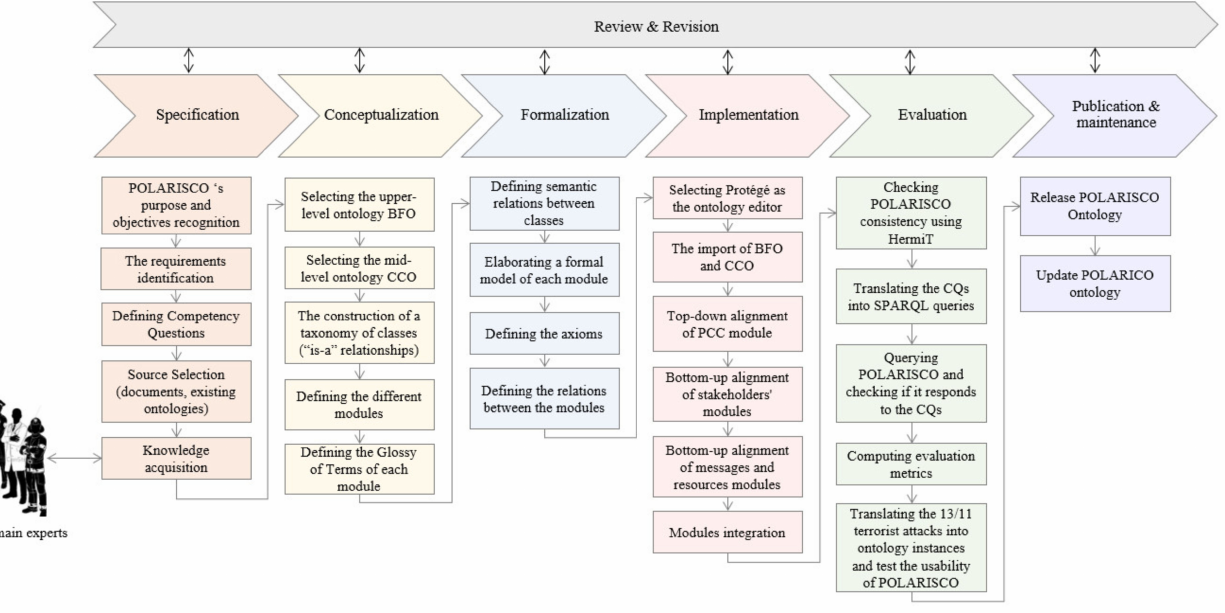
Figure 26. The sequences of steps of POLARISCO development